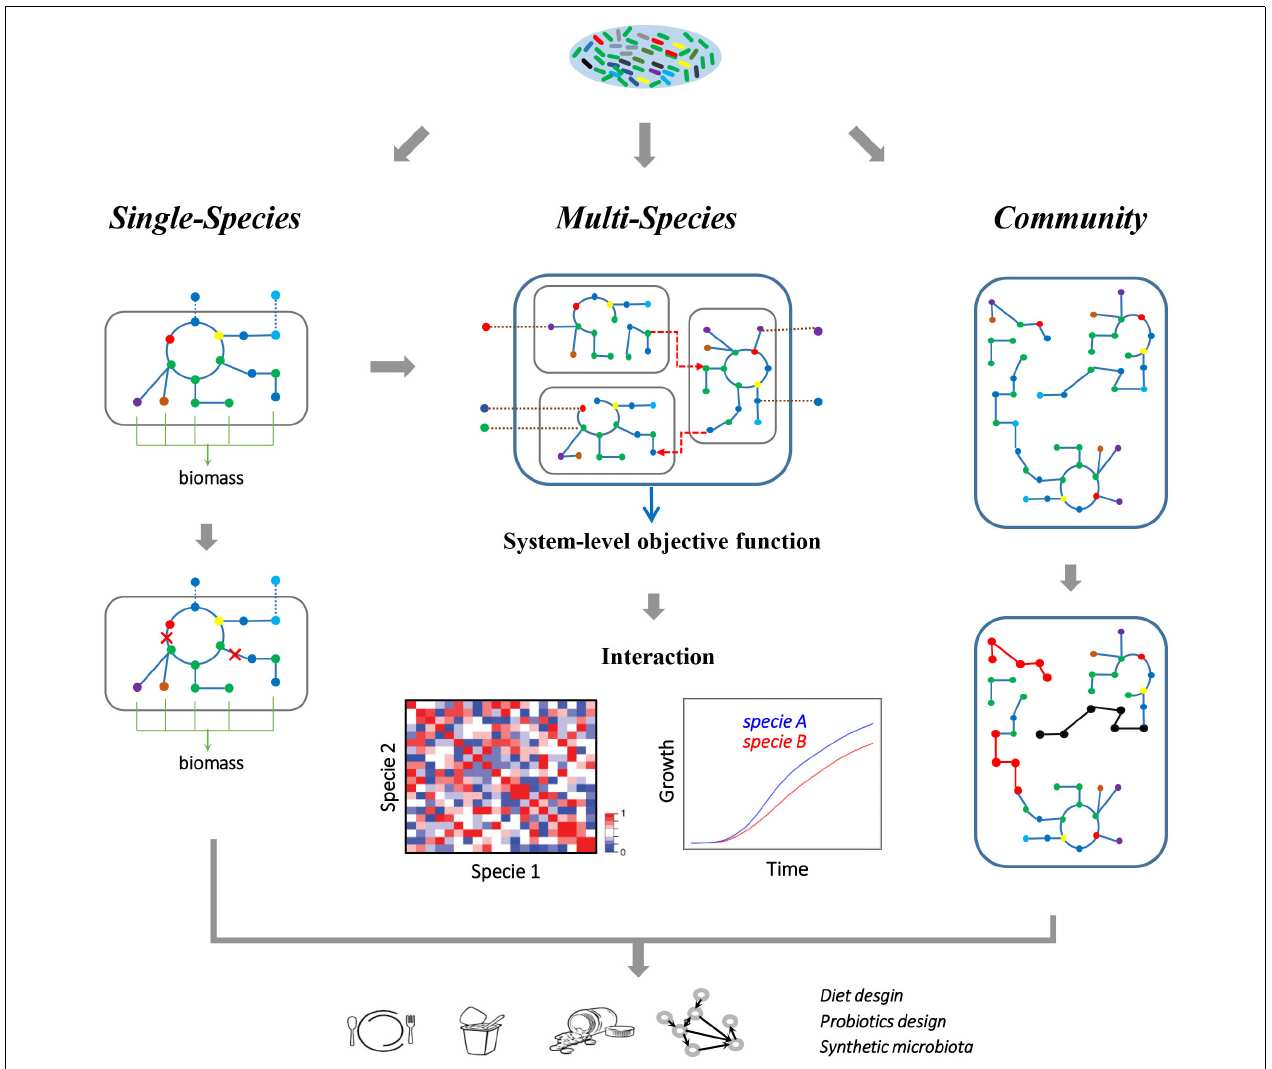
FIGURE 2 | Metabolic modeling of the gut microbiome. A single-species GEM is defined as a set of biochemical reactions that occur in a living microorganism, which can be reconstructed starting from the corresponding genome annotation. Here, a single-species model is illustrated, where nodes represent metabolites and edges represent reactions, while the dashed lines indicate exchanges of metabolites between cells and environment. The metabolic capacity and gene essentiality of the single gut species can be inferred using FBA. While multi-species GEMs consider each specie as an individual component, and combine each component with a joint in silico environment where the nutrients are supplied. The dashed arrows here indicate the metabolic interactions between different microbial species. With such a multi-component approach, metabolic related phenotype of the whole